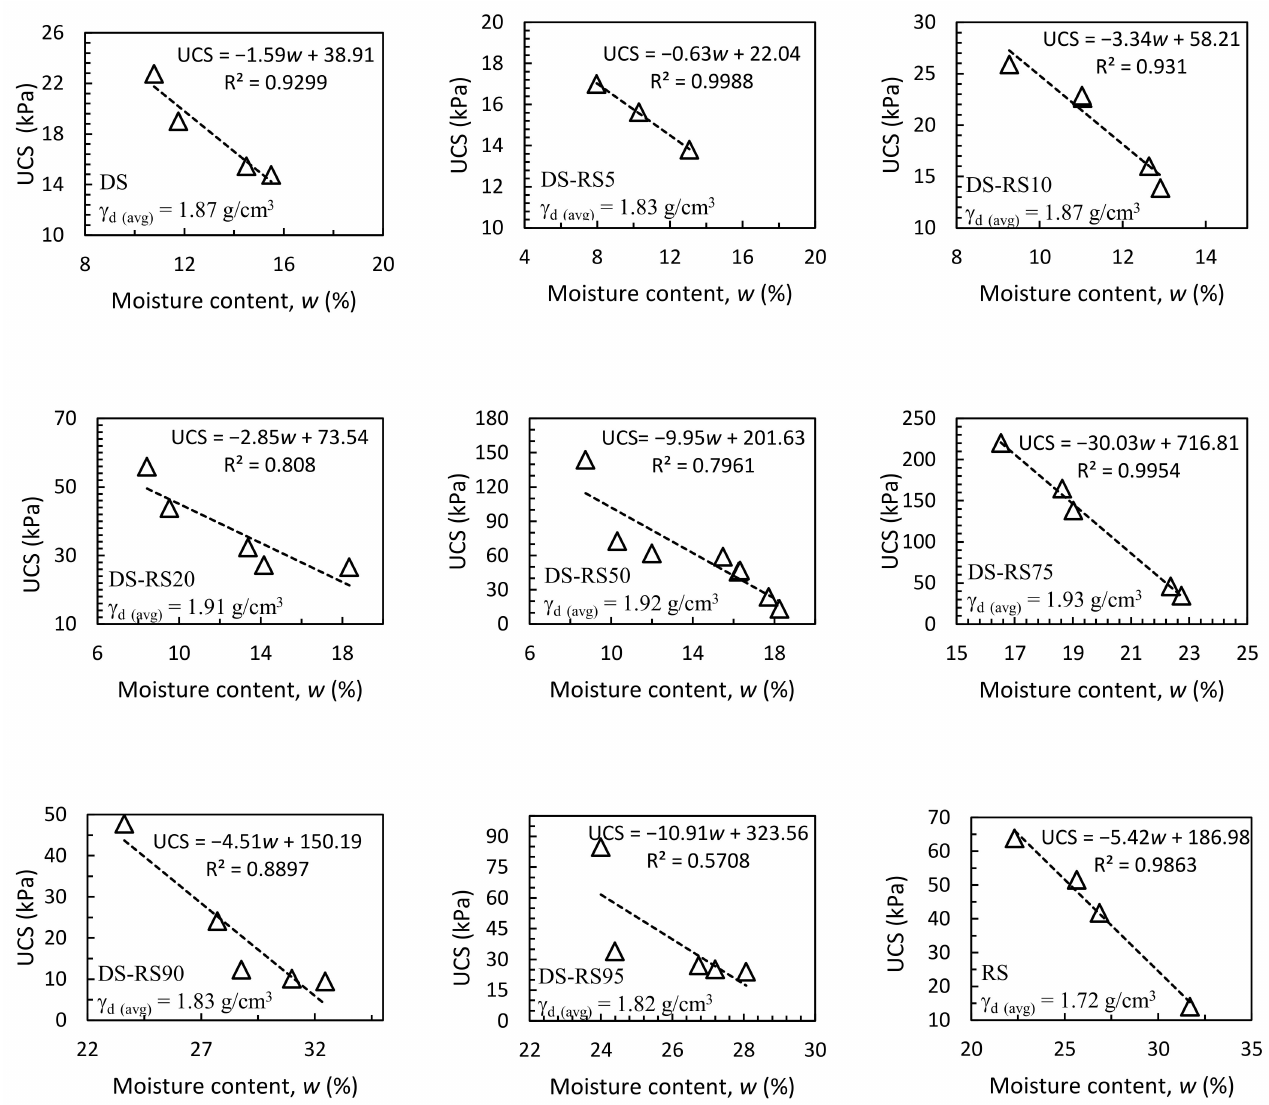
Figure 9. Effect of moisture content on unconfined compressive strength of sand-sediment